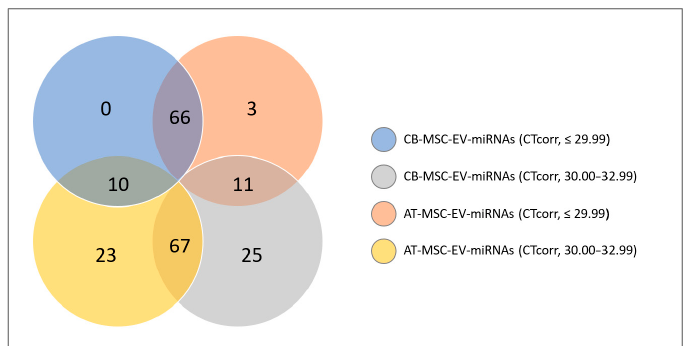
Figure 5. Heatmap and dendrograms of all microRNAs (miRNAs) detected with certainty according to the guidelines of the Qiagen-Exiqon miRCURY LNA Universal RT microRNA PCR system. Sample IDs are shown on the x-axis. Samples with similar miRNA expression are clustered together. The heatmap was generated by RStudio and 2 dCT was used for data input. Z-scores of more than zero indicate a higher expression of miRNAs in one sample compared to the others; Z-scores of less than zero indicate the opposite.